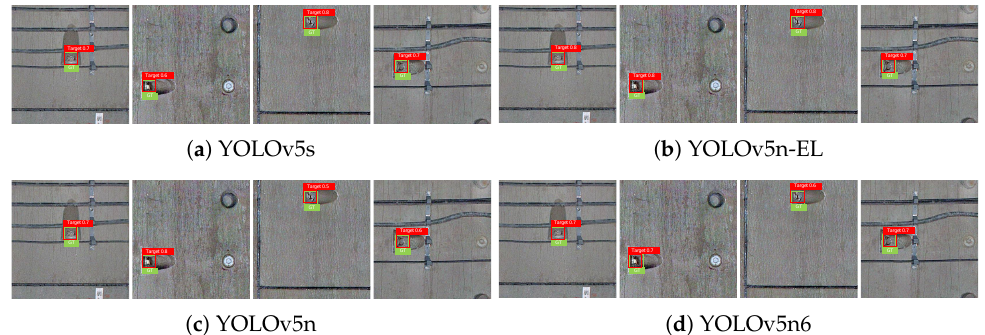
Figure 11. Examples of detection results with MSRCR color